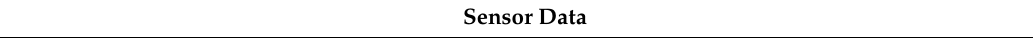
Table 2. Features extracted from smartwatch